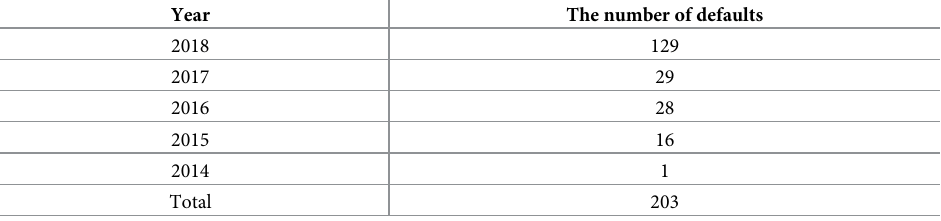
Table 2. The number of defaults on corporate bonds rated high ratings.